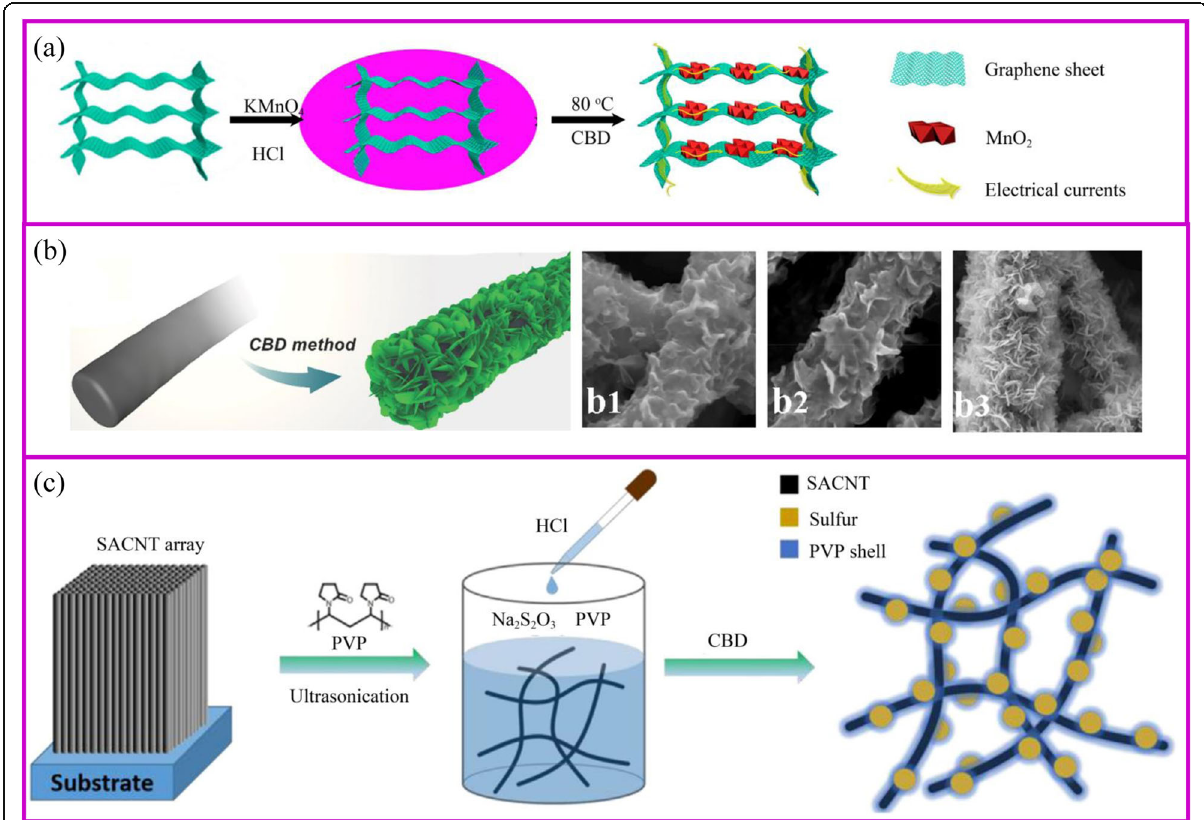
Fig. 4 a Schematic illustration of the preparation of 3D graphene/MnO 2 hybrid, and illustrations of electrons transfer on 3D graphene/MnO 2 hybrid [59]. b CBD method for the fabrication of CNF@Ni(OH) 2 [60]. b1 – 3 Different hybrid membranes with increase of concentrations of Ni(NO 3 ) 2 solution. c Schematic of the synthesis procedure for the PVP@S-SACNT composite